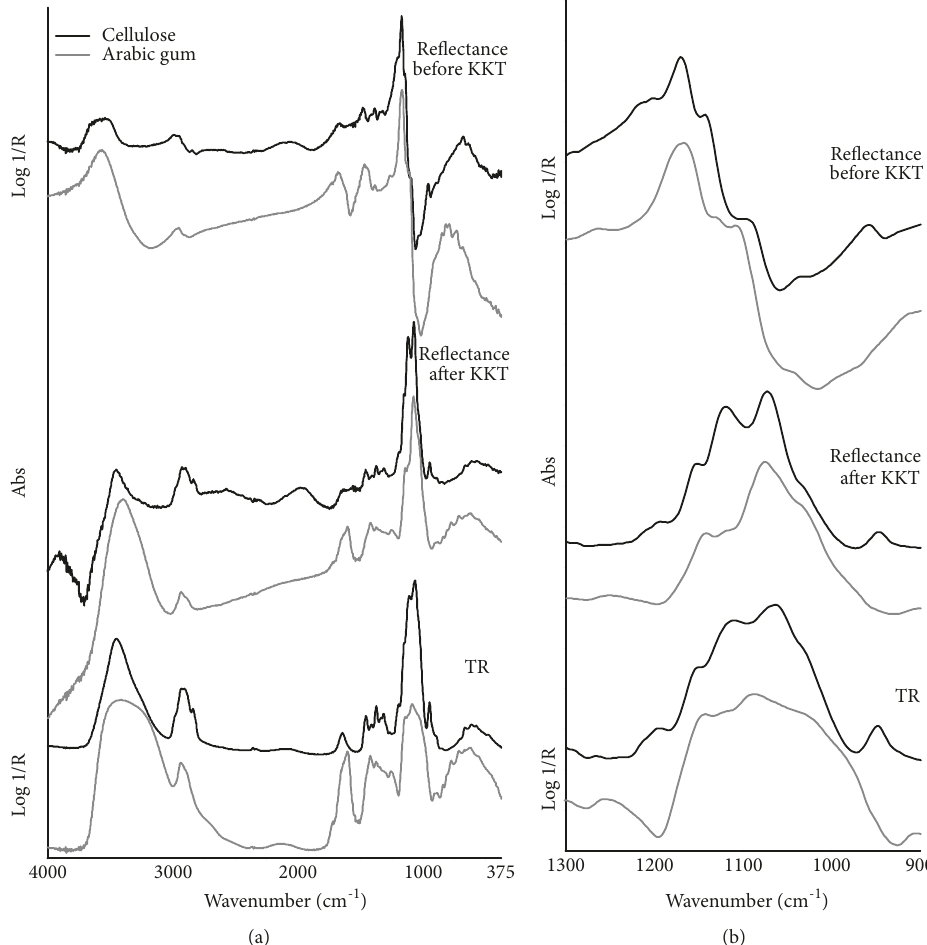
Figure 5: FTIR spectra in the mid-infrared region of the studied polysaccharide materials (black line: cellulose, gray line: Arabic gum) using differentanalysis modes. From toptobottom: totalreflectionmode beforetheKKT correction,total reflectionmodeafter theKKT correction, and transflection mode. Spectral regions of (a) 4000-375cm −1 and (b) C-O stretching